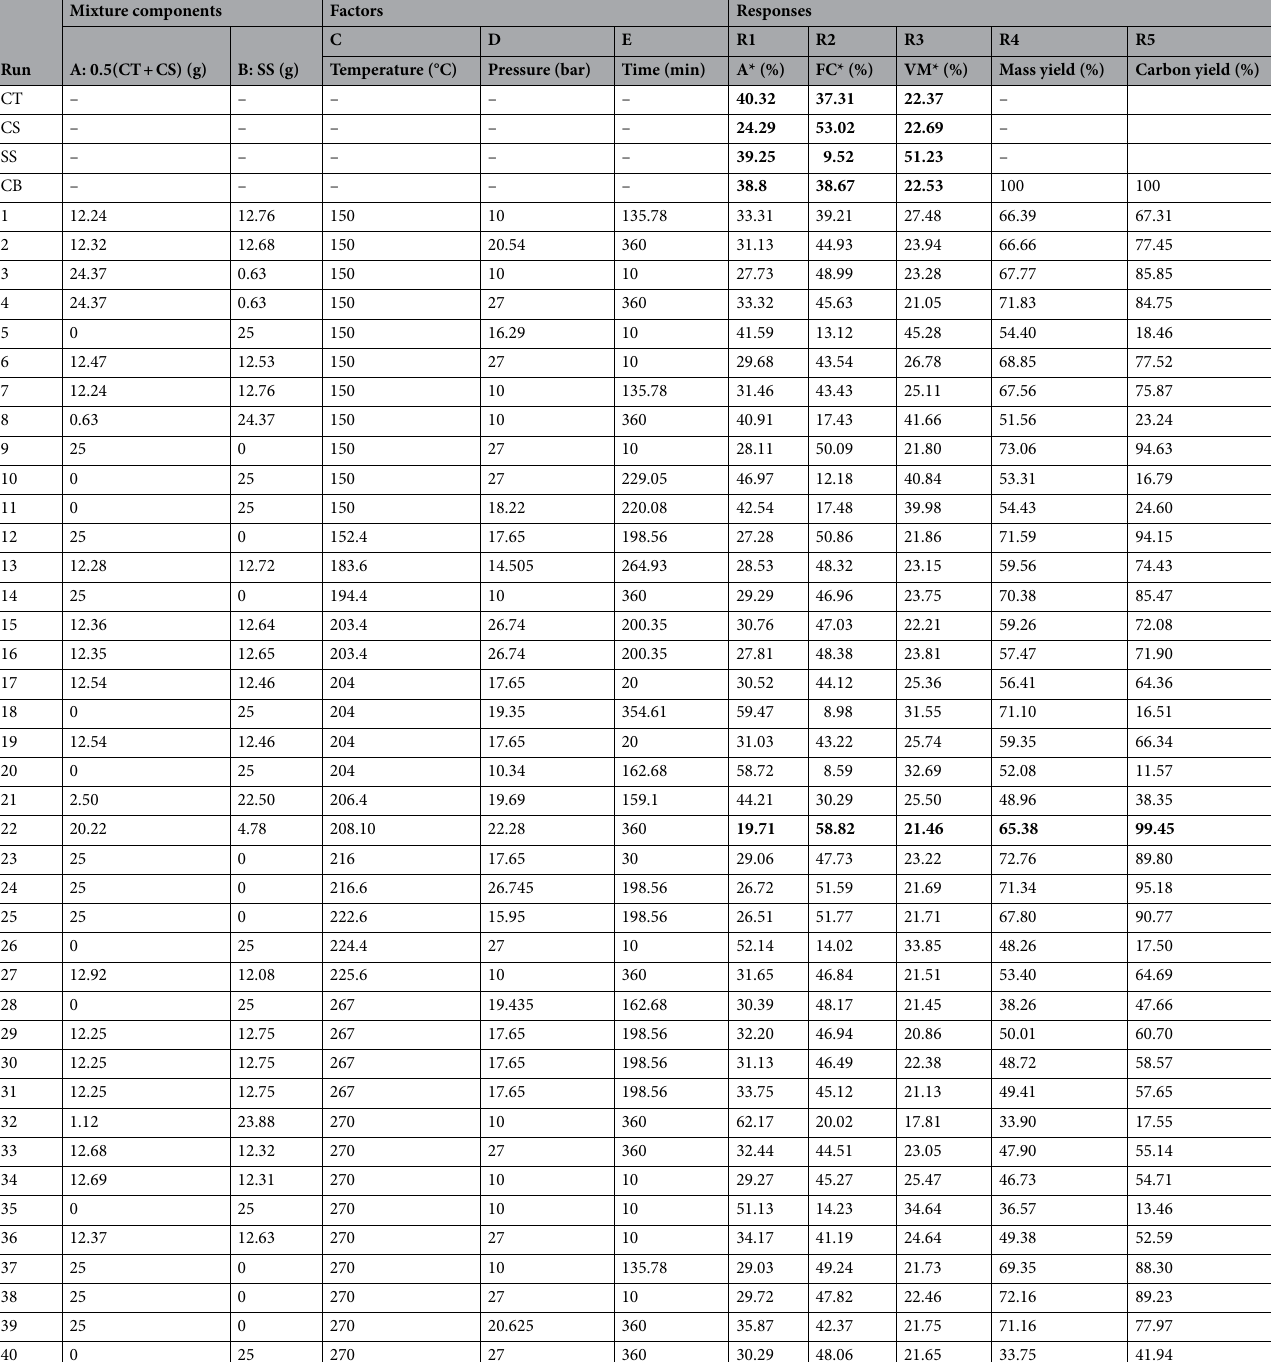
Table 5. Physicochemical results of HC from mixture of CD and SS. Significant values are in bold. HC hydrochar, SS sewage sludge, CT coal tailing, CS coal slurry, min minutes, °C degrees celsius, A ash content,